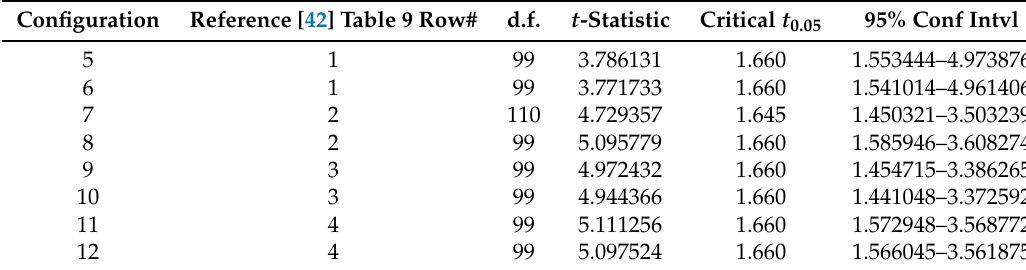
Table 21. The method in [42] versus Jaya: results of Smith–Satterthwaite tests for comparing the means of 100 best-of-run costs for each